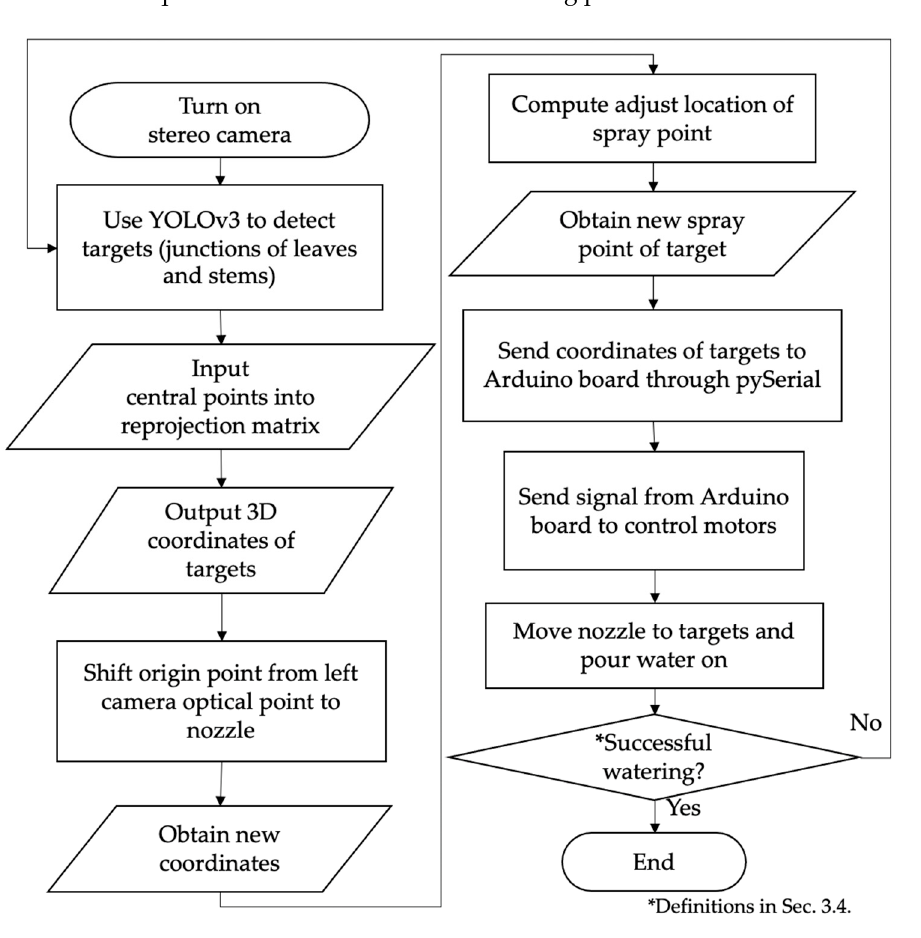
Figure 2. Flow chart from object detection (YOLOv3) to automatic watering process.